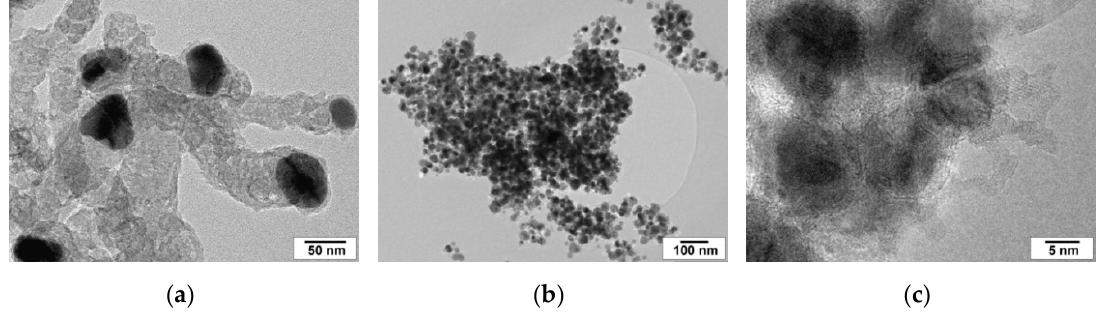
Figure 10. TEM images of the carbonaceous deposits produced over Ni/Al 2 O 3 catalyst during the processing of C 6 H 5 Cl at 550 °C: ( a ) without addition of H 2 ; ( b ), ( c ) in the presence of H 2 (50 vol%).